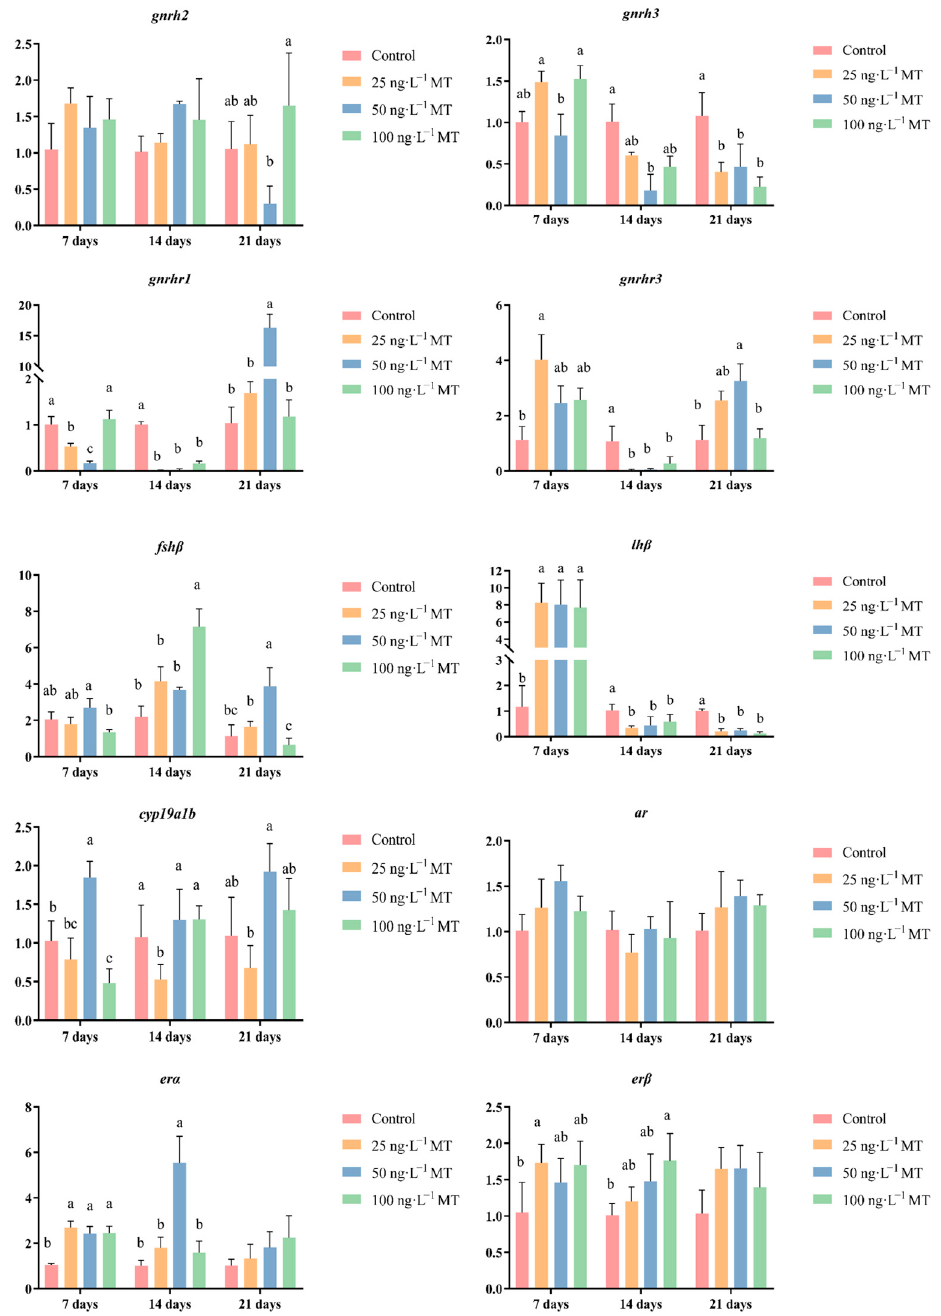
Figure 4. Effect of MT on gnrh2 , gnrh3 , gnrhr1 , gnrhr3 , fsh β , lh β , cyp19a1b , ar , er α , and er β genes in the brain of male G. rarus . Data are expressed as mean ± SD. Different letters indicate statistically significant differences ( p <